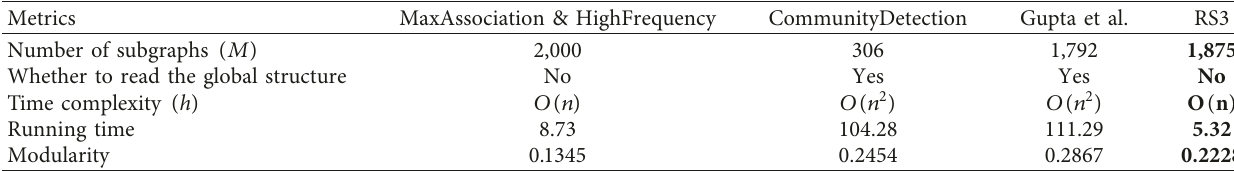
Table 2: Comparison of subgraph partitioning algorithms on SubGraphData.